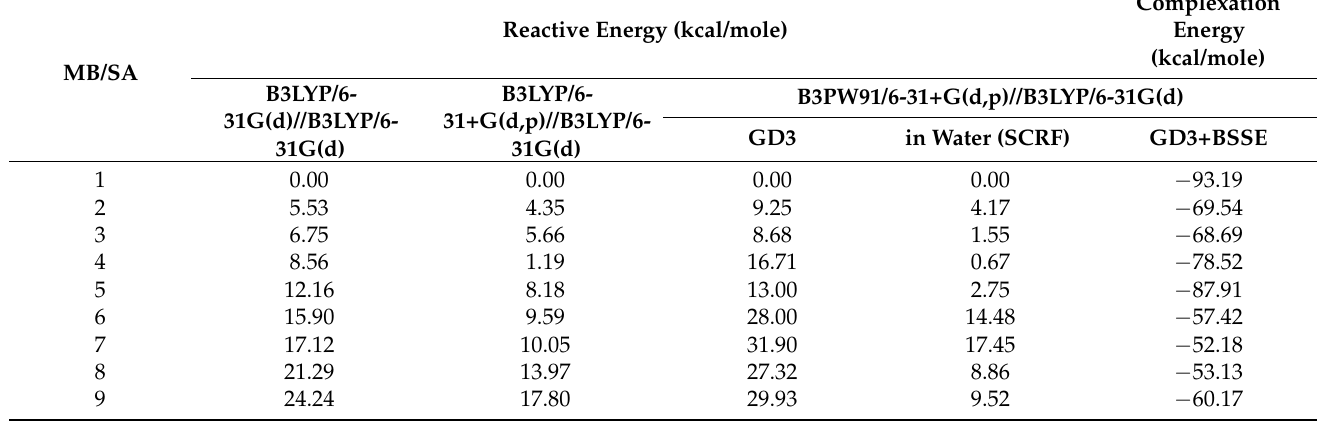
Table 3. The reactive energies and complexation energies of MB/sodium alginate (MB/SA) complex.